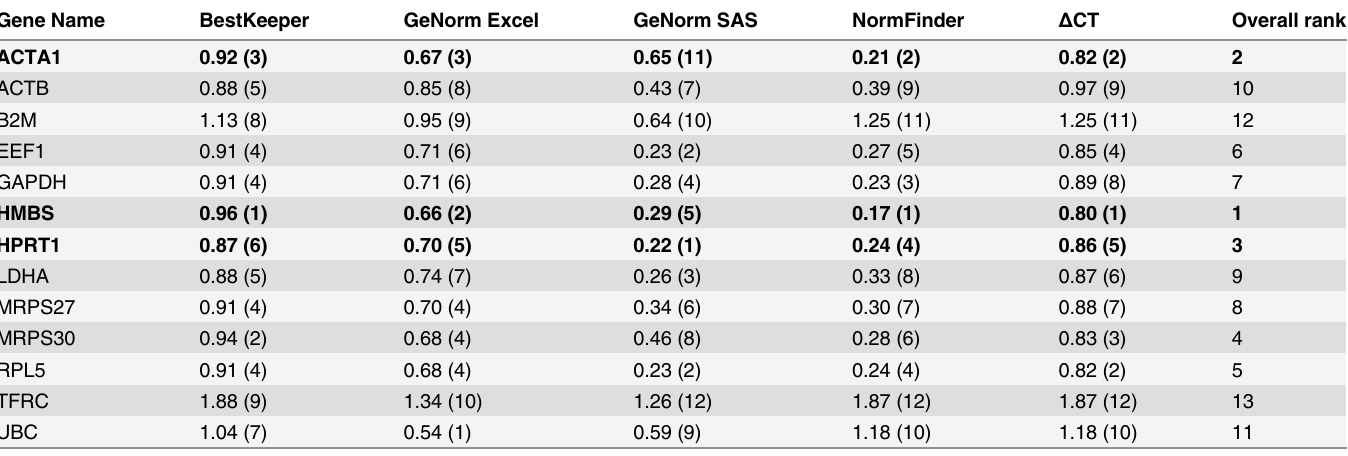
Table 4. Results of ranking of thirteen reference genes obtained using five different algorithms and overall rank of candidate reference genes for chicken muscle. Three overall best references genes are indicated in bold. Gene